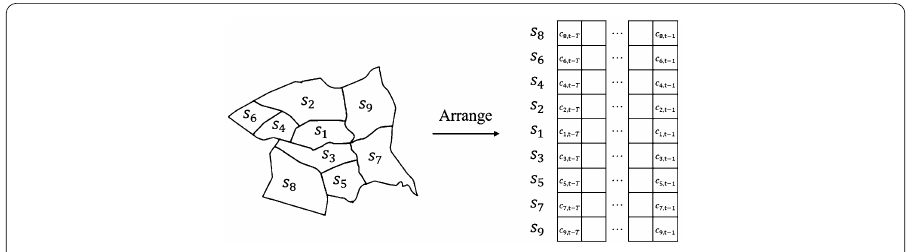
Figure 2 Arrange the nearest neighbors set for the target census tract s 1 and construct the 2D feature map for historical crimes. In the neighboring set of s 1 , s 2 and s 3 is the closest to s 1 ; s 4 and s 5 are the next closest to s 2 and s 3 respectively; s 6 and s 7 are the next closest to s 4 and s 5 ; s 8 and s 9 are the next closest to s 6 and s 7 . Similar process is applied to each of the ten mobility